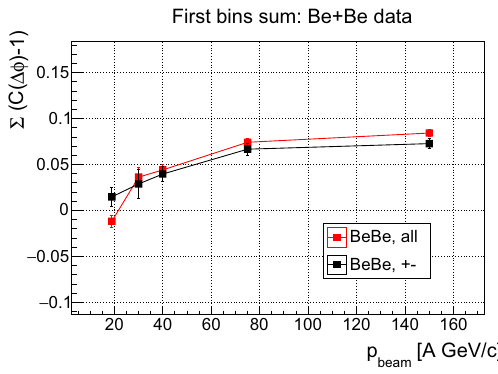
First bins sum: Be+Be data